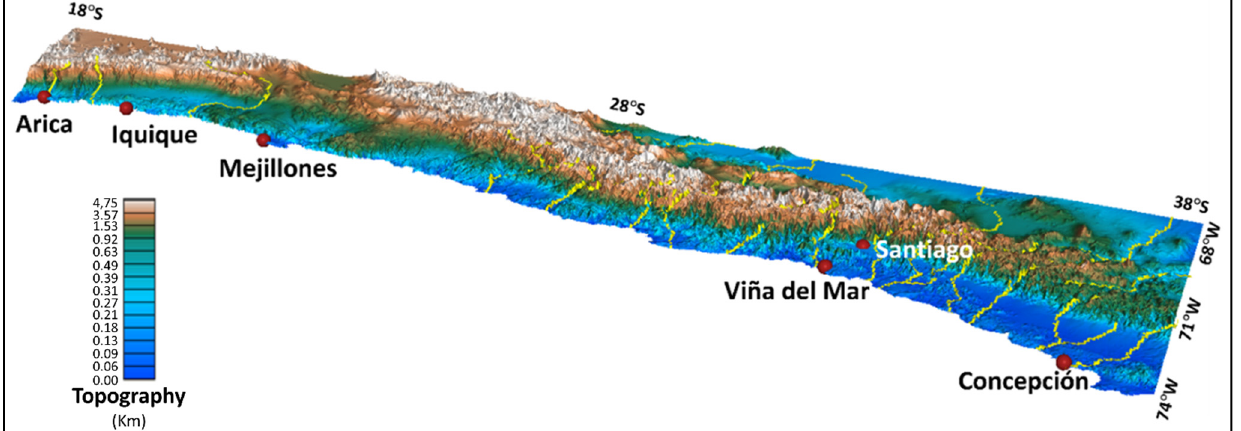
Figure 1. Location of all the cities used in this research. The background of the figure corresponds to the topographic map (Shuttle Radar Topography Mission 1 Arc-Second Global (Digital Object Identifier (DOI) number:/10.5066/F7PR7TFT)) and the yellow lines correspond to the main fluvial system in the zone.